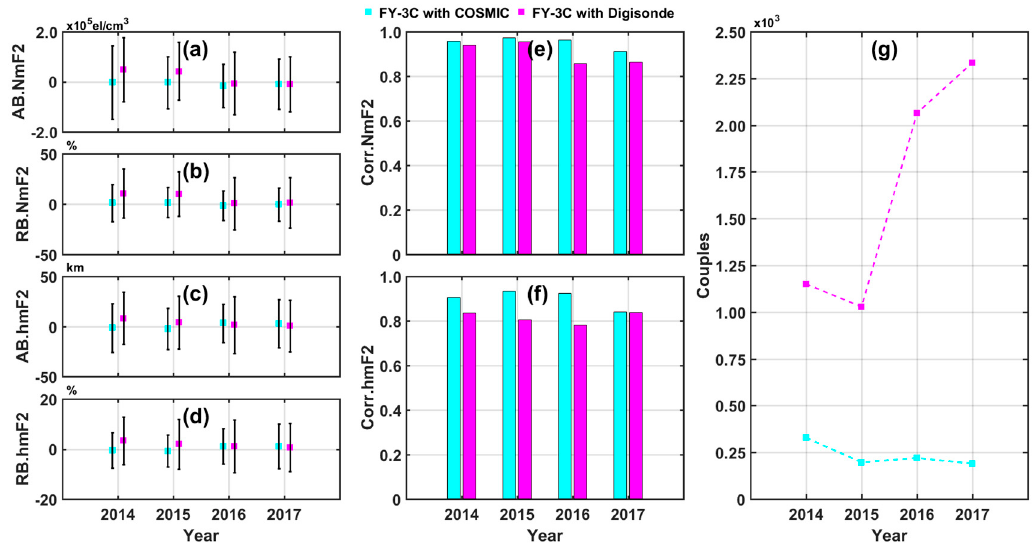
Figure 8. The comparison between FY-3C RO-derived ICPs and ICPs from other observations (COSMIC RO and digisonde) for each year during 2014–2017 for ( a ) ABs of NmF2, ( b ) RBs of NmF2, ( c ) ABs of hmF2, ( d ) RBs of hmF2, ( e ) CCs of NmF2, ( f ) CCs of hmF2 and ( g ) the number of the couples.